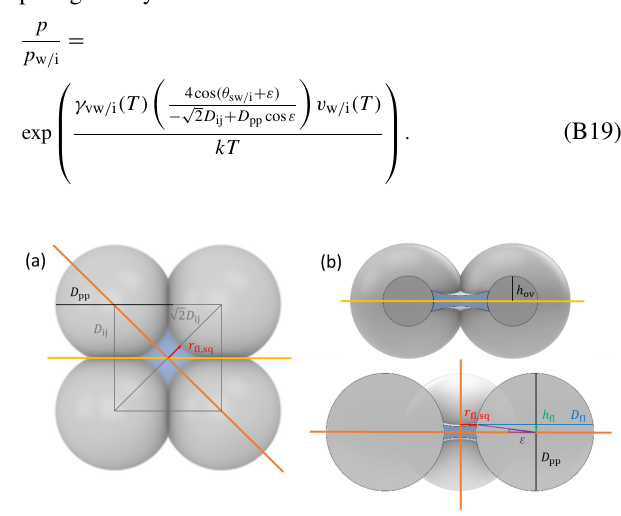
Figure B6. Illustration of filling of a four-membered ring pore in (a) top view and (b) side views. Bright and dark orange lines in panel (a) indicate the cross sections shown in the side views de- picted in panel (b) . The pore filling is illustrated for a liquid water filling level to h fr = 1 . 25nm, but the same geometry also applies for filling the pore with